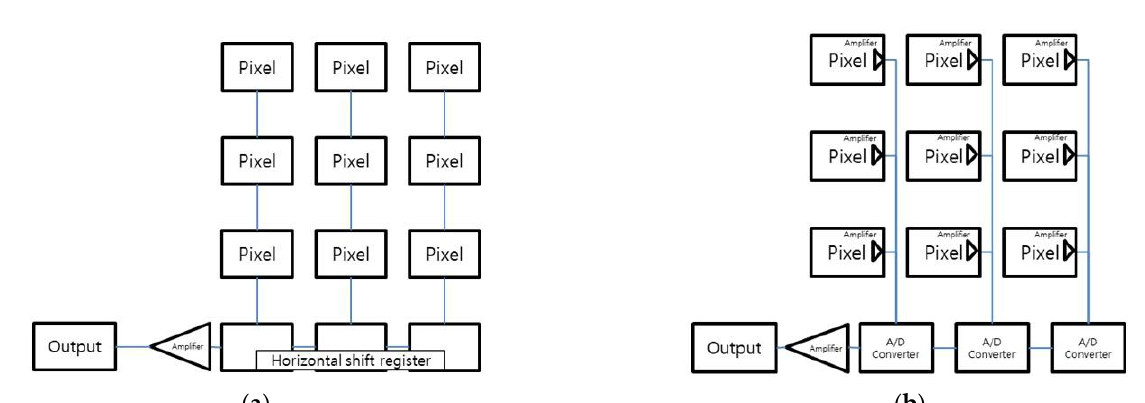
Figure 6. Difference between CCD and CMOS sensors: ( a ) CCD sensor array and ( b ) CMOS sensor array.